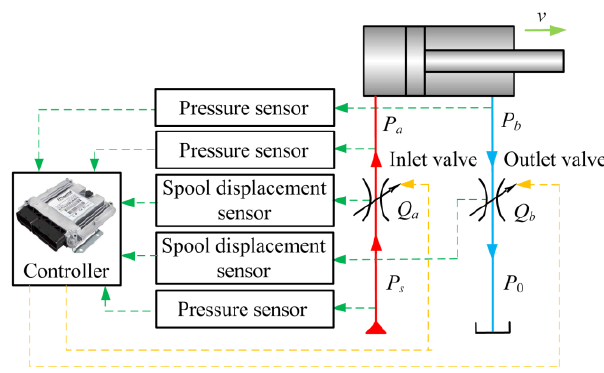
Figure 4. Electro-hydraulic pressure compensation method.